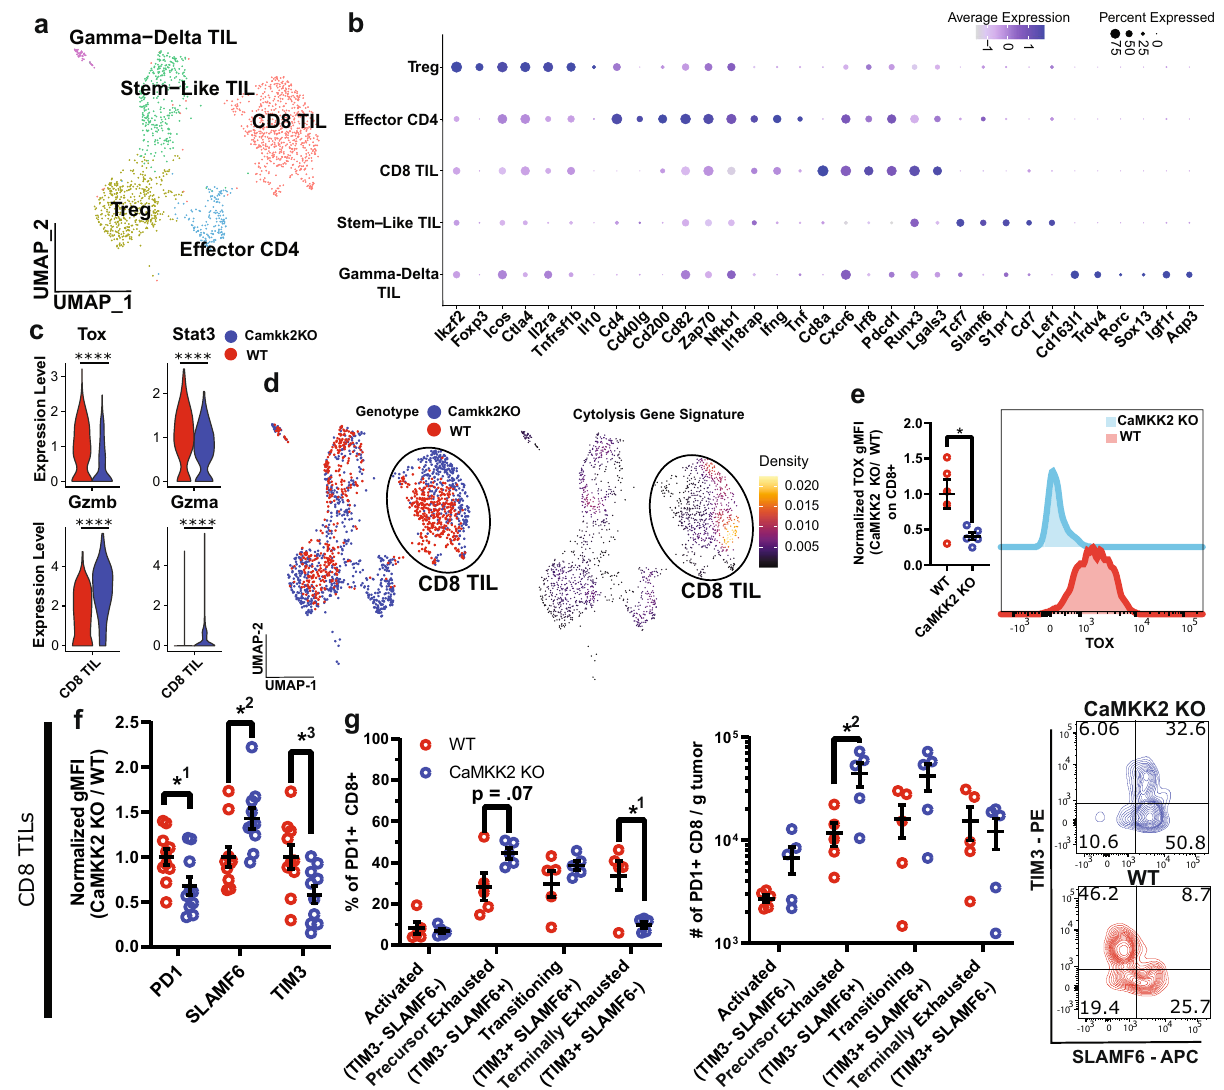
Fig. 3 | CaMKK2 de fi ciency averts a terminally exhausted phenotype in tumor- in fi ltrating CD8 + T cells.a UMAP plots of reclustered TILs presented in aggregate b Dot plots corresponding to the cell clusters displayed in the UMAP plot in panel a show expression of subset-speci fi c genes. c Violin plots comparing exhaustion and cytolytic genes expression in CD8 + TILs. MAST was used for differential expressionanalysis. n =366WTand n =350CaMKK2.****adj. p <0.0001. d UMAPof reclusteredTILs(sameembeddingaspanel a )strati fi ed bygenotype,andadensity plot of the cytolysis gene signature projected into UMAP space. e Tumor-bearing hemispheres were harvested on D14 post CT2a implantation and stained with a multi-color fl ow panel to assess Tox expression in CD8 + TILs. n =5 per genotype,